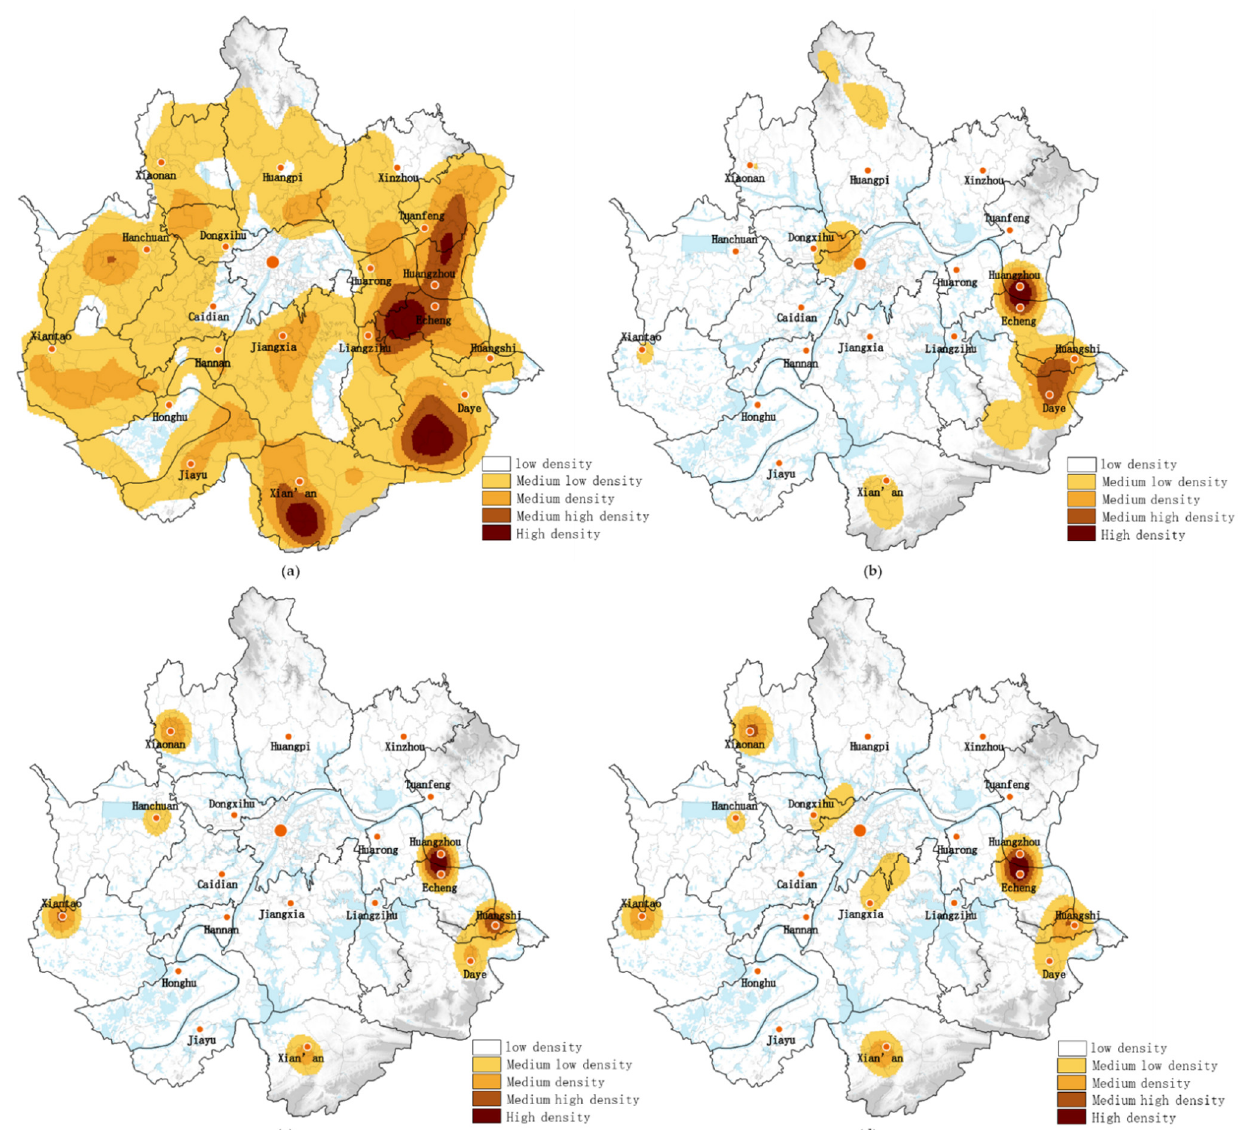
Figure 7. Nuclear density analysis of agricultural enterprises ( a ), scenic spots ( b ), medical facilities ( c ), and educational facilities ( d ) in the Wuhan metropolitan area.